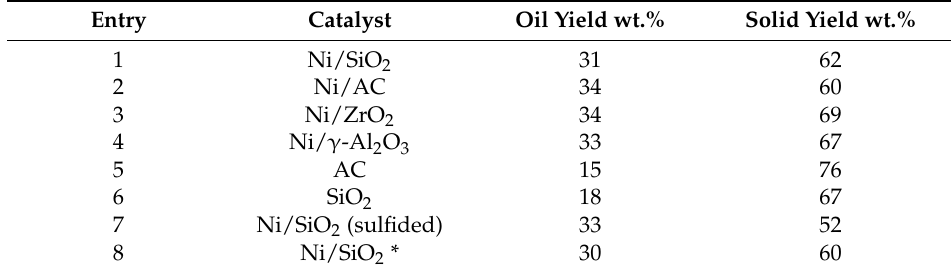
Table 5. The oil and solid yields from conversion of H-LS over Ni-based catalyst in EtOH. Reaction temperature of 250 ◦ C, 3 h reaction time. Entry Catalyst Oil Yield wt.% Solid Yield